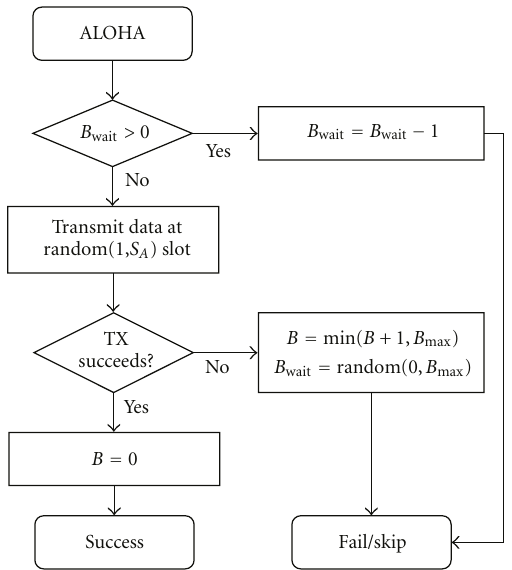
Figure 4: Contention-based channel access with ALOHA-based